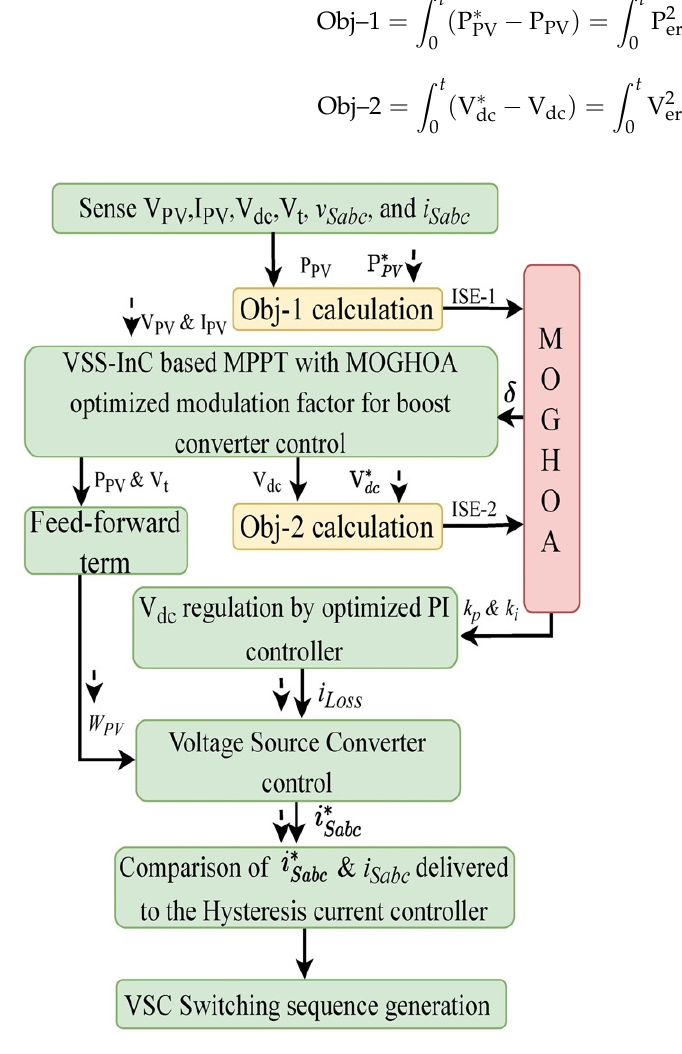
Figure 2. Research methodology.